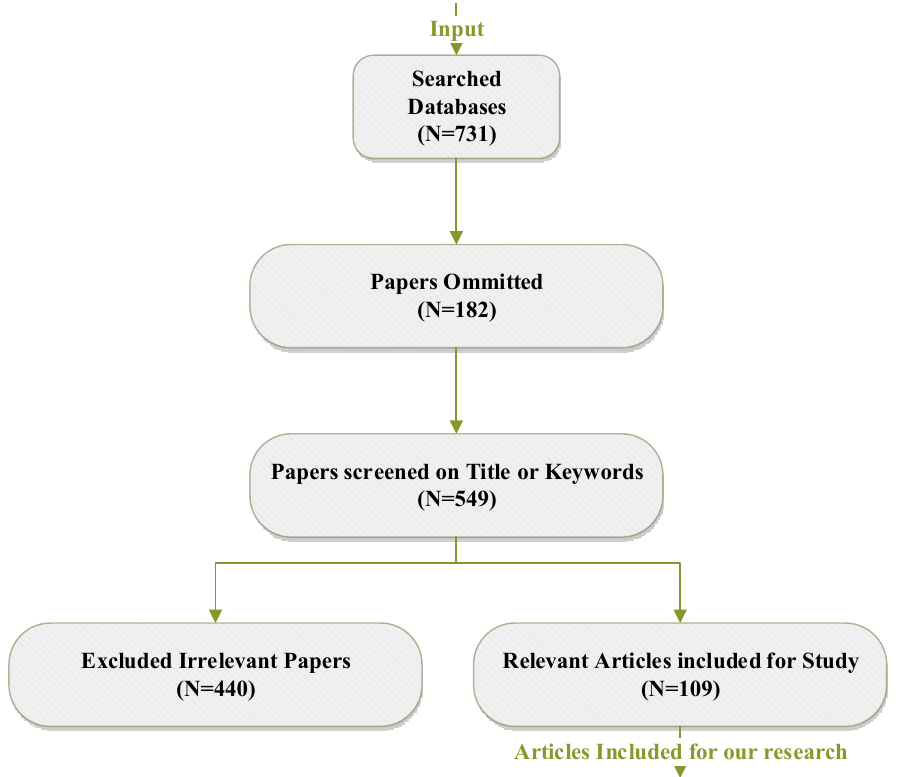
Figure 2. Relevant and irrelevant papers selection